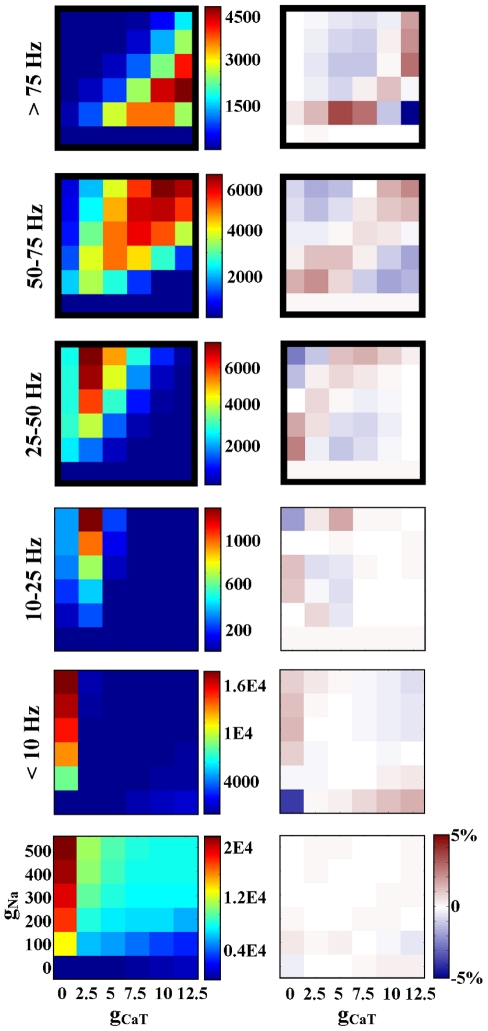
Values of gNa and gCaT are correlated for spiking models with a frequency greater than 25 Hz.Bold black borders indicate a correlation (χ2>500 and |ρ|>0.2).